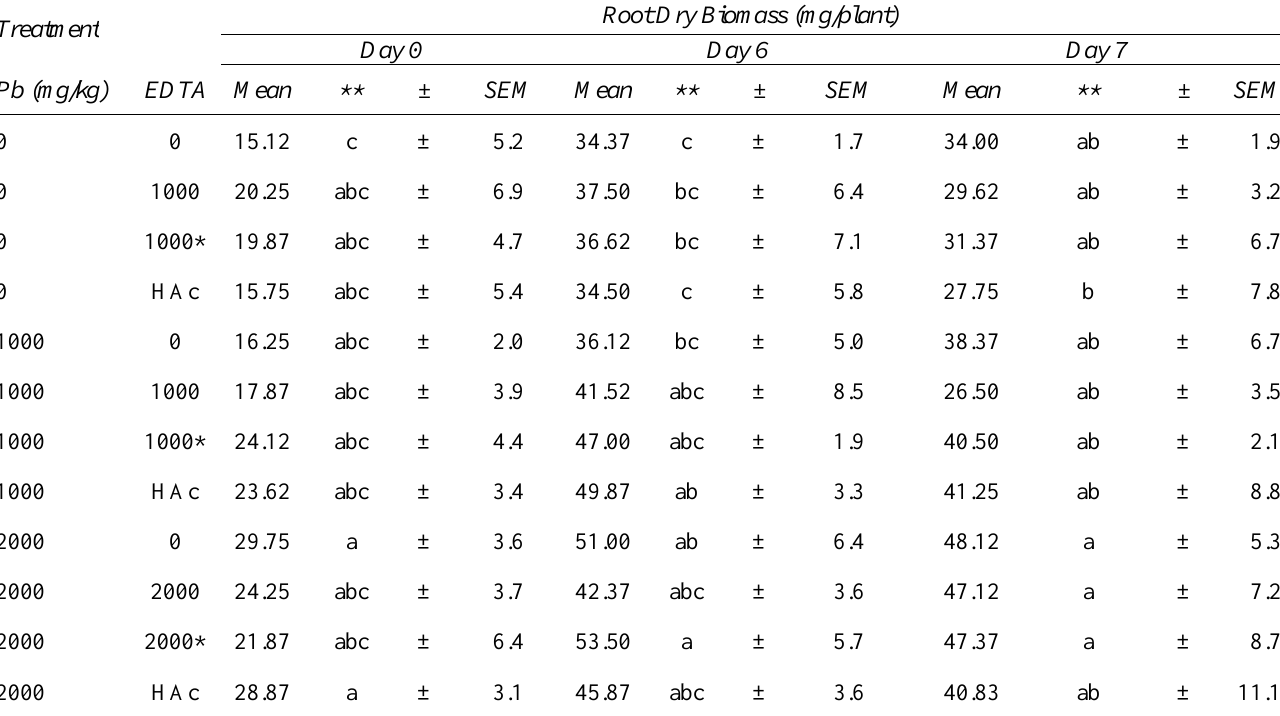
Table 2 : Effects of lead and chelates on root dry biomass of Sesbania exaltata Raf. at 0, 6, and 7 days after chelate application